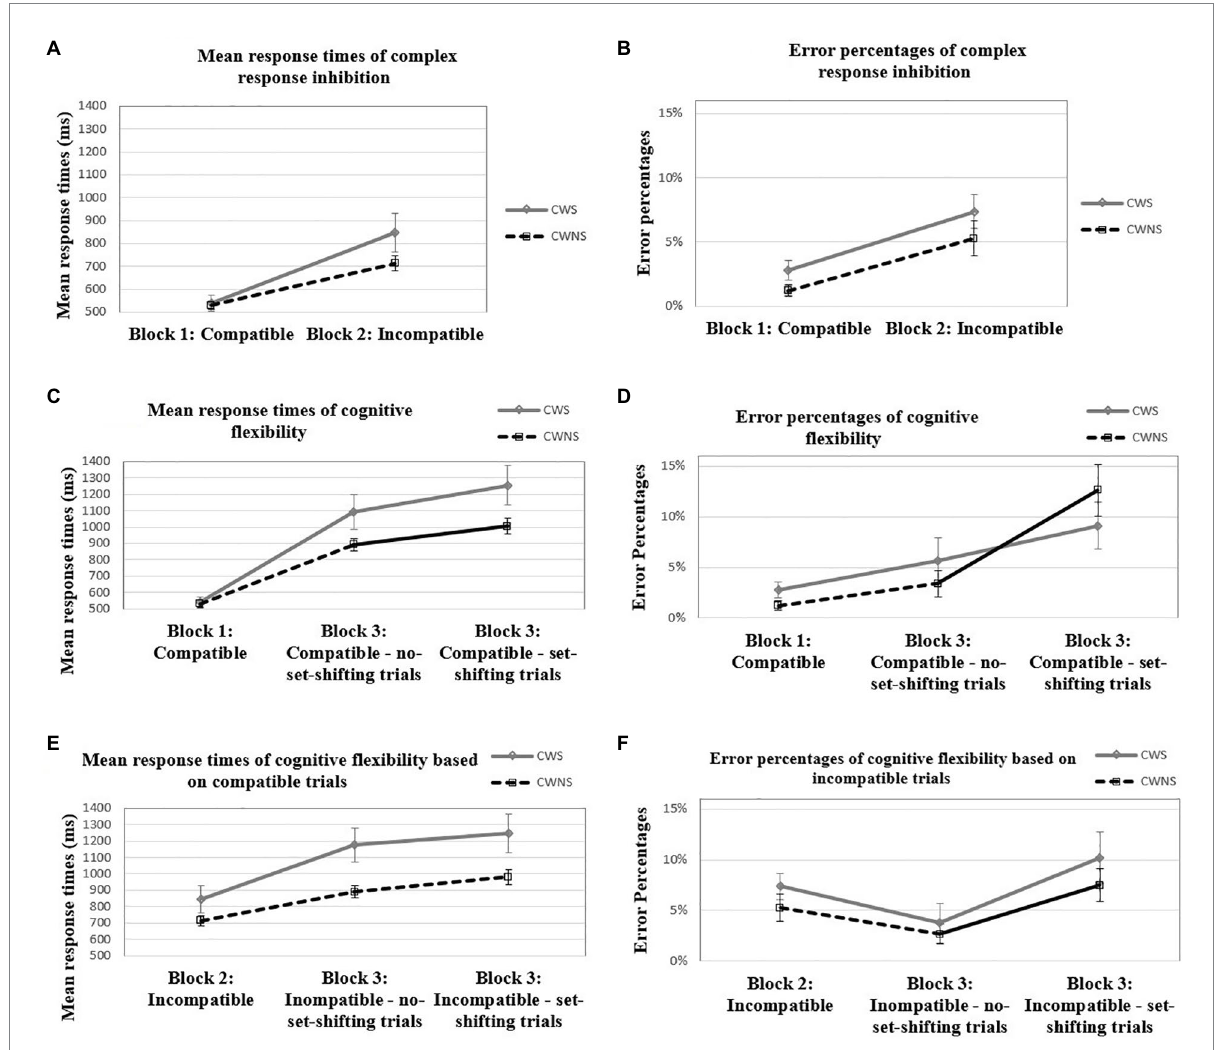
FIGURE 2 Mean response times (in ms) and error percentages of complex response inhibition (A, B) , mean response times (in ms) and error percentages of cognitive flexibility based on compatible trials (C, D) , and mean response times (in ms) and error percentages of cognitive flexibility based on incompatible trials (E, F) for the CWS and CWNS